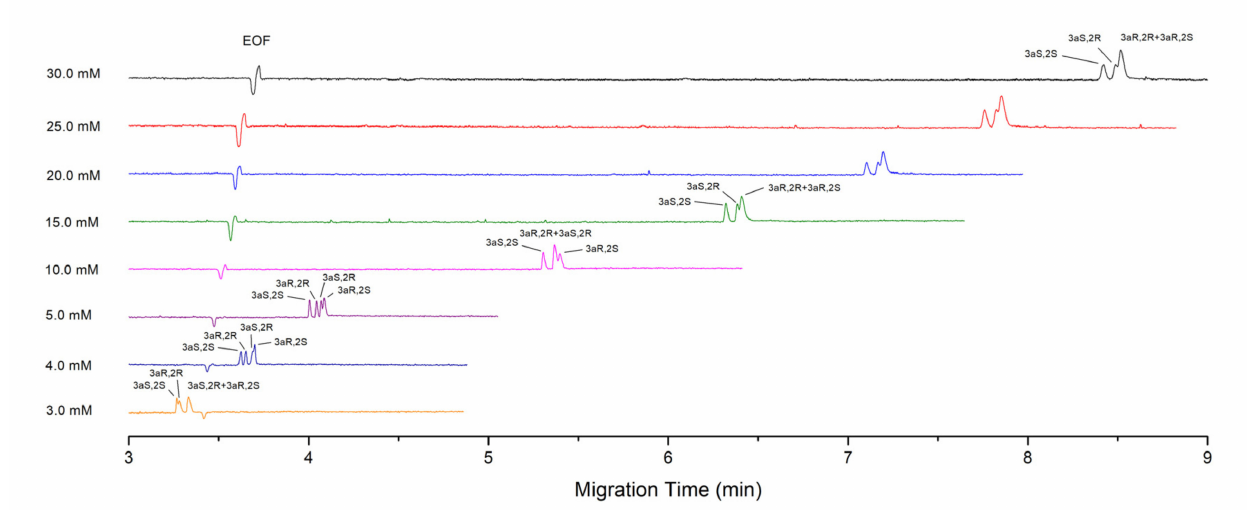
Figure 3. Electropherograms of PALO stereoisomers obtained with different concentrations of STDC. Component of micellar solution is STDC of annotated concentrations in 30 mM sodium tetraborate buffer of pH 9.2. Sample concentration: 0.1 mg · mL − 1 for each stereoisomer. Hydrodynamic injection at 5 kPa, 2 s and 1 s for the STDC concentration of 30.0–10.0 mM and 5.0–3.0 mM, respectively. Detection wavelength: 254 nm. Other CE conditions are the same as in Figure